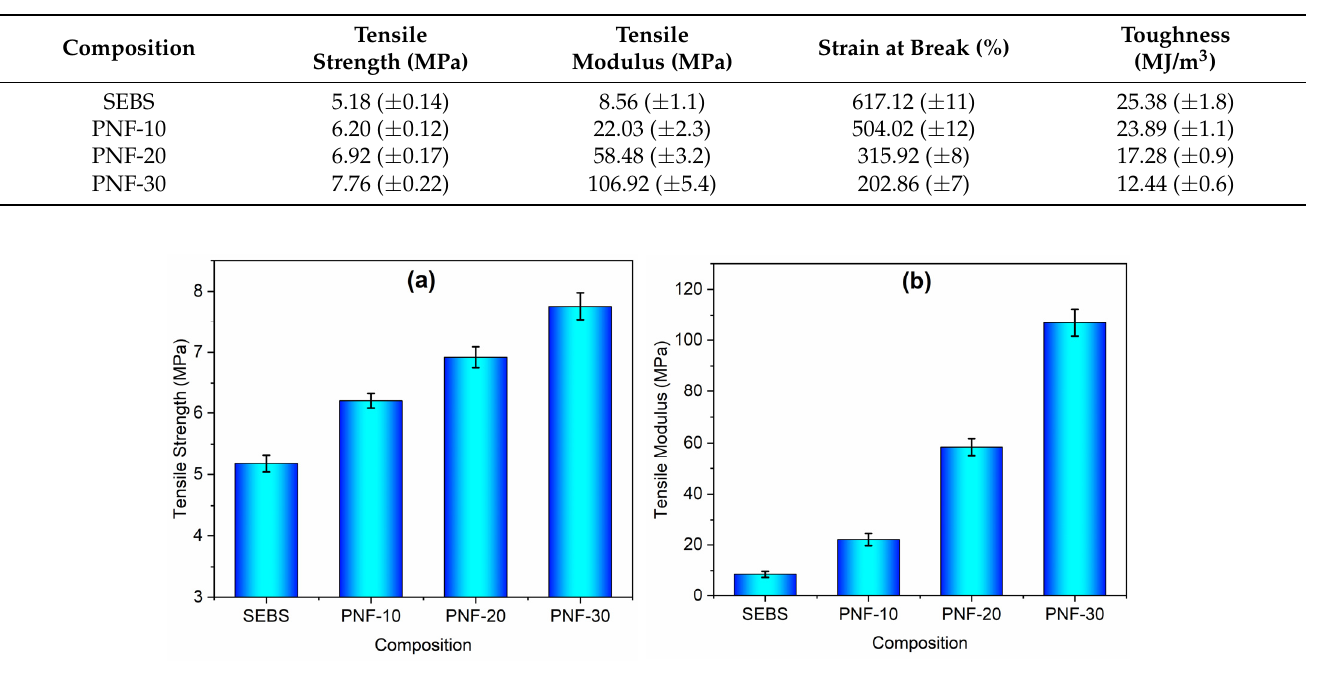
Figure 4. Tensile stress vs. strain curves of the matrix and the composites. Table 2. Tensile behavior of the materials. Table 2. Tensile behavior of the materials.